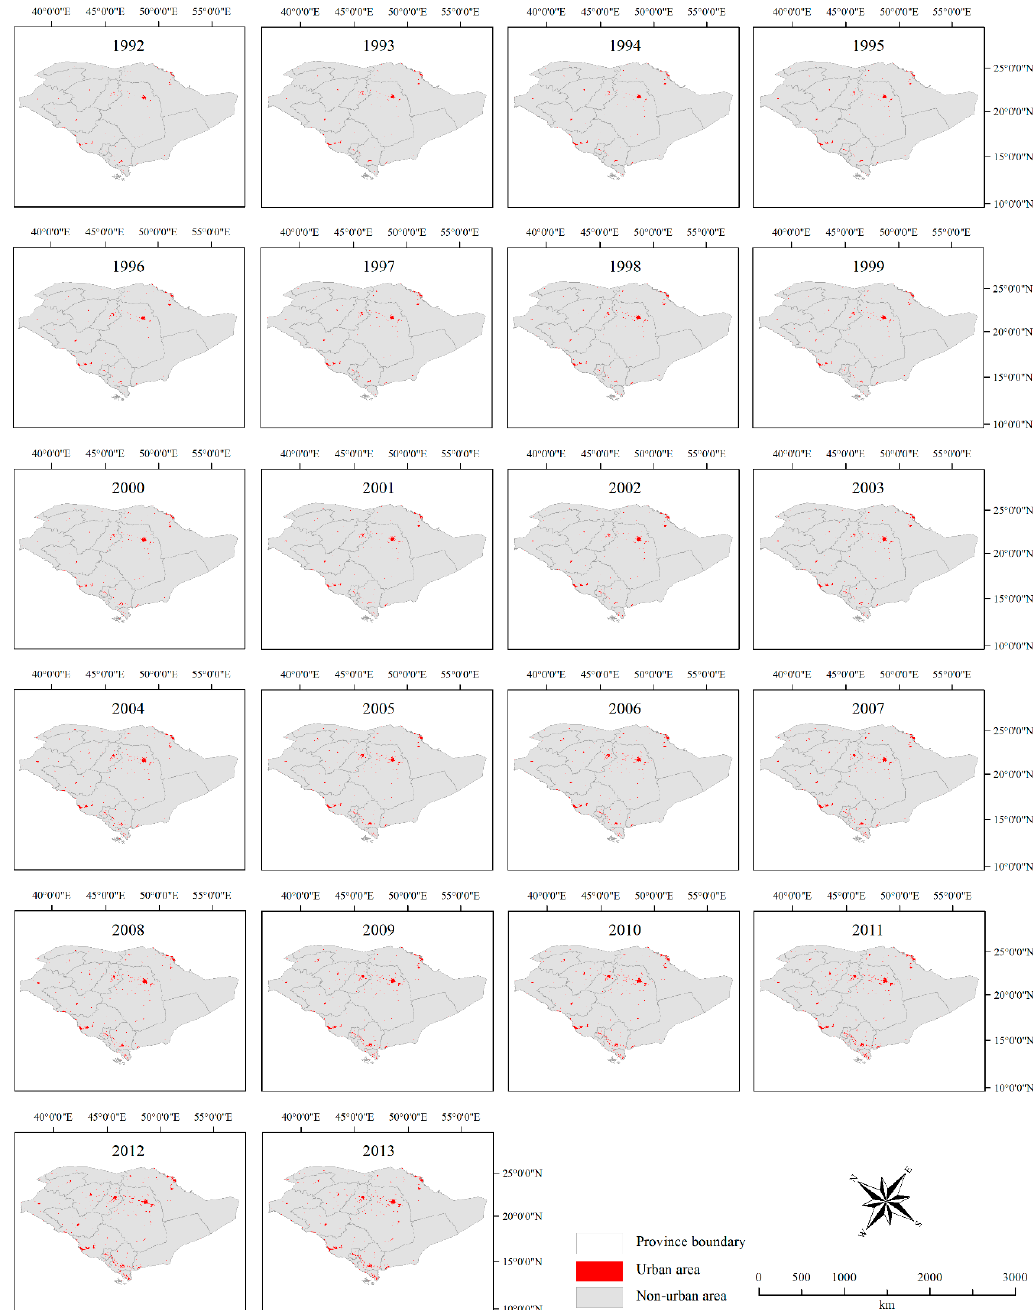
Figure 7. Maps of urban area across Saudi Arabia from 1992 to 2013 derived from the calibrated DMSP-OLS SNT data.